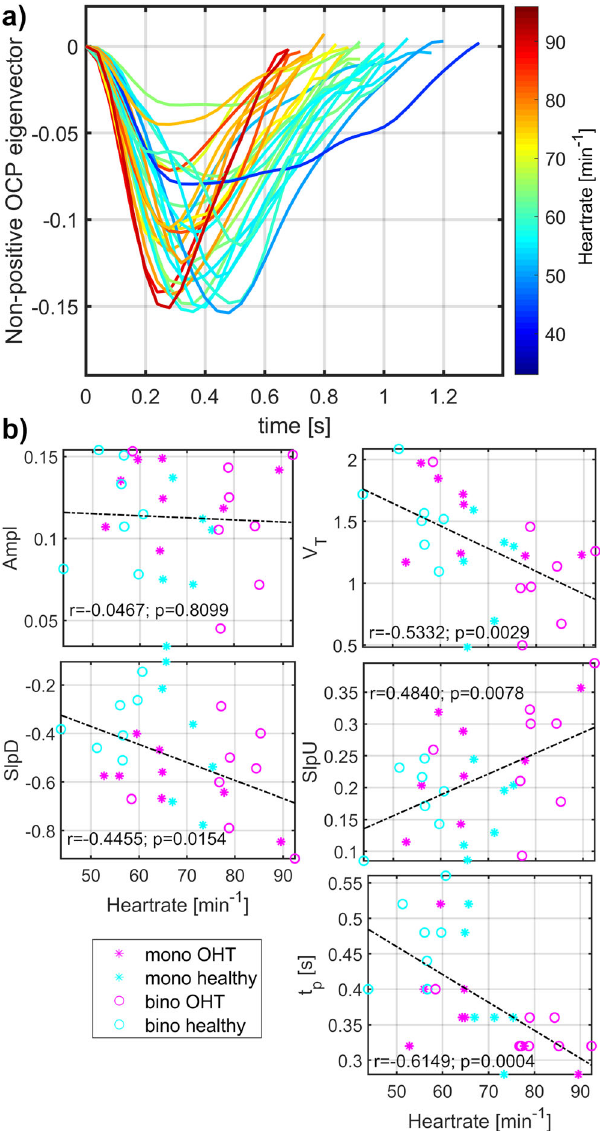
Fig. 2 Heart rate modulated morphology of spontaneous venous pulsations (SVP). a Visualization of mean single-pulses over all monocular (mono) and binocular (bino) retinal video-recordings from healthy controls and patients with medicated ocular hypertension (OHT). Graph lines are heart rate color-coded. b Evaluation of linear dependence between heart rate and SVP morphology measurements (Ampl amplitude of the SVP eigenvector, V T total relative pulse stroke volume in the eigenvector measures, SlpD slope-down from the eigenvector value at the period beginning to the negative eigenvector peak ≈ peak of the maximal absolute blood volume time-point, SlpU slope-up from the negative eigenvector peak to the period end, t p time to the negative eigenvector peak). Value r represents a corresponding Pearson correlation coef fi cient and value p the p -value of the correlation level.